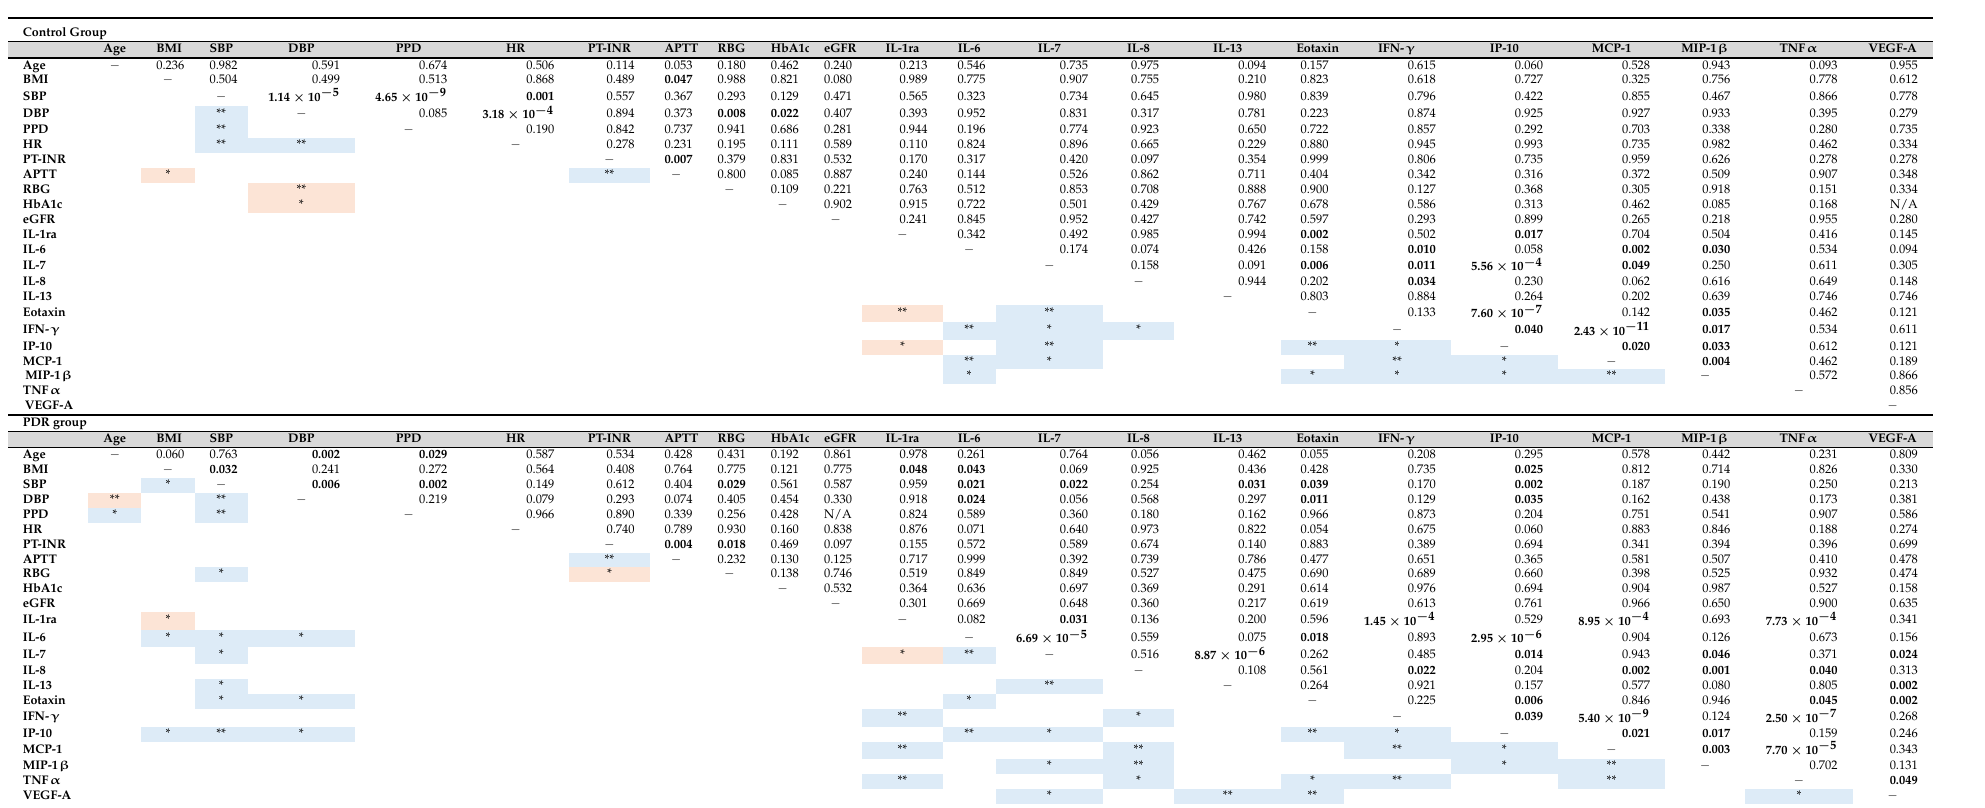
Table 3. Correlation matrices with significance levels for systemic factors and vitreous fluid cytokines in PDR patients and